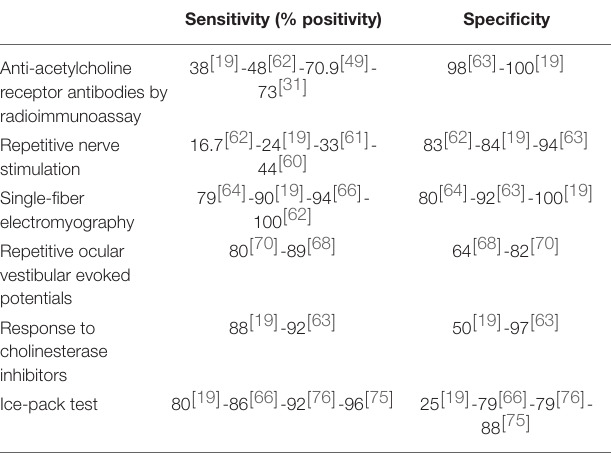
TABLE 1 | Sensitivity and specificity of diagnostic tests in ocular myasthenia gravis. Sensitivity (%